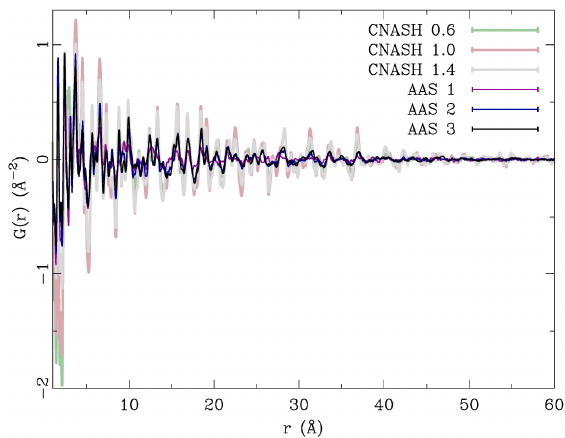
Figure 7. Synchrotron ‐ derived X ‐ ray pair distribution functions of real and synthetic sodium ‐ containing calcium ‐ alumino ‐ silicate ‐ hydrate (C ‐ (N) ‐ A ‐ S ‐ H) gels showing the extent of ordering in each sample. Three real C ‐ (N) ‐ A ‐ S ‐ H gels (denoted as AAS 1, AAS 2 and AAS 3)